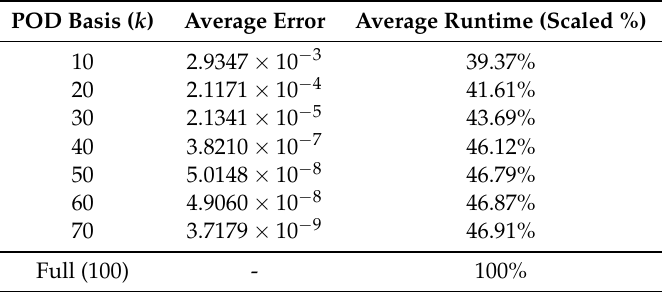
Table 4. [Test 2] Average runtime and average error of the POD reduced systems with parameter values (cid:101) = 0.2,0.5 and 0.8.